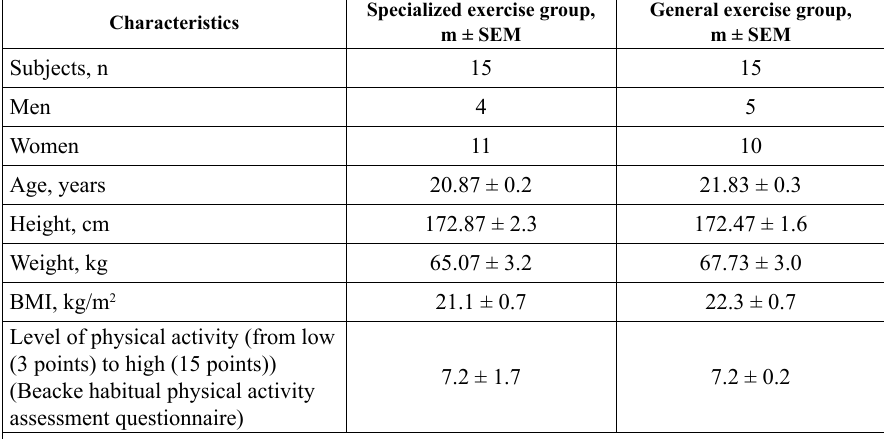
characteristics